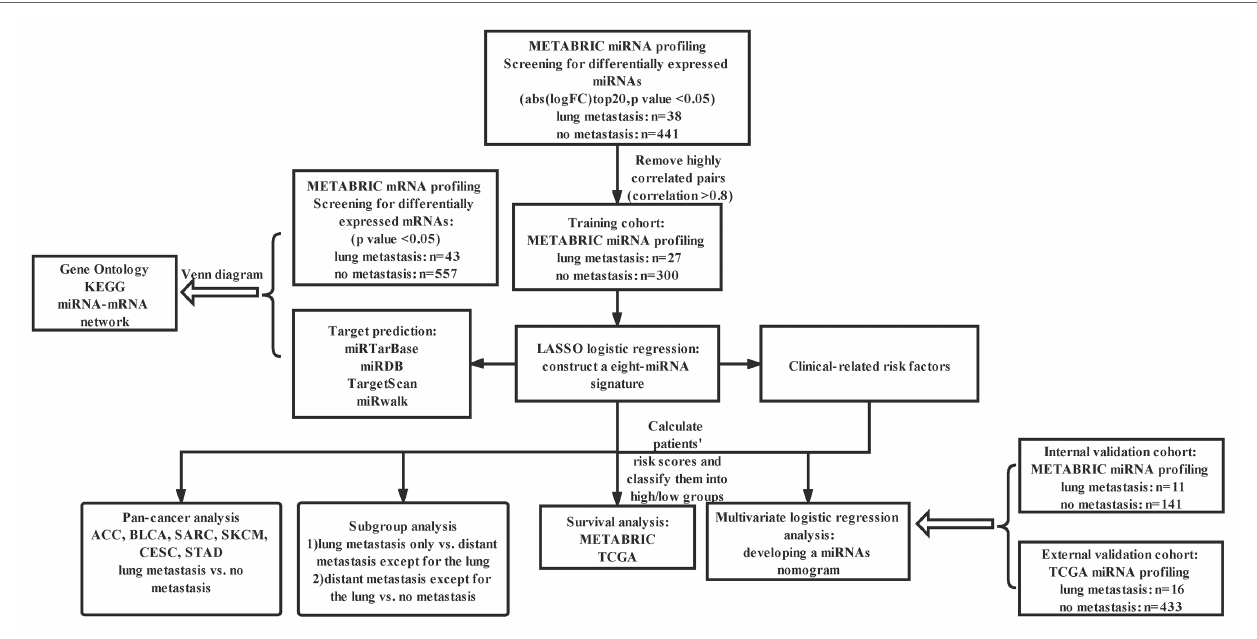
FIGURE 1 | Study design. METABRIC, molecular taxonomy of BC international consortium; LASSO, the least absolute shrinkage and selector operation; KEGG, Kyoto encyclopedia of genes and genomes; Abs, absolute value; FC, fold change; miRNA, microRNA; and TCGA, the cancer genome